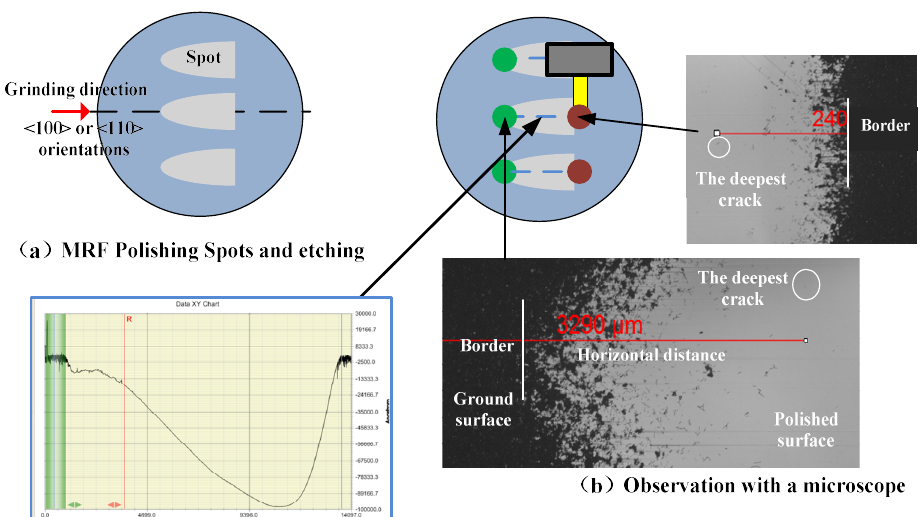
Figure 4. The sub-surface damage (SSD) measurement by spot magnetorheological finishing tech- nique. (a) MRF Polishing spots and etching. (b) Observation with a microscope. (c) Measured two-dimensional profile of spot.